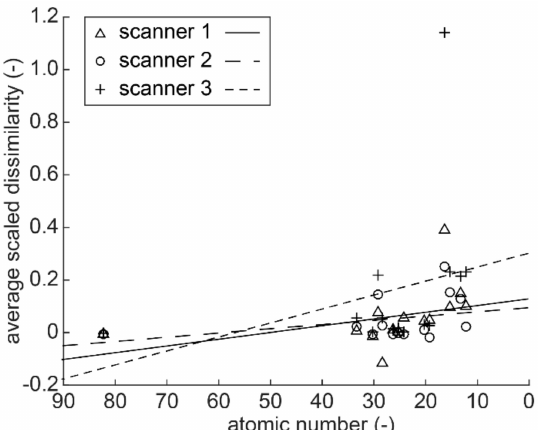
Figure 5. Sensitivity of X-ray fluorescence (XRF) to the atomic weight of the elements. Relationship between the elements’ atomic numbers (Z) and the corresponding average scaled dissimilarities for the three tested scanners. A least-squares linear regression line is shown for each scanner. Results for Cd were left out of the regression analysis as the lack of data for scanner 1 and 3 would give biased results.